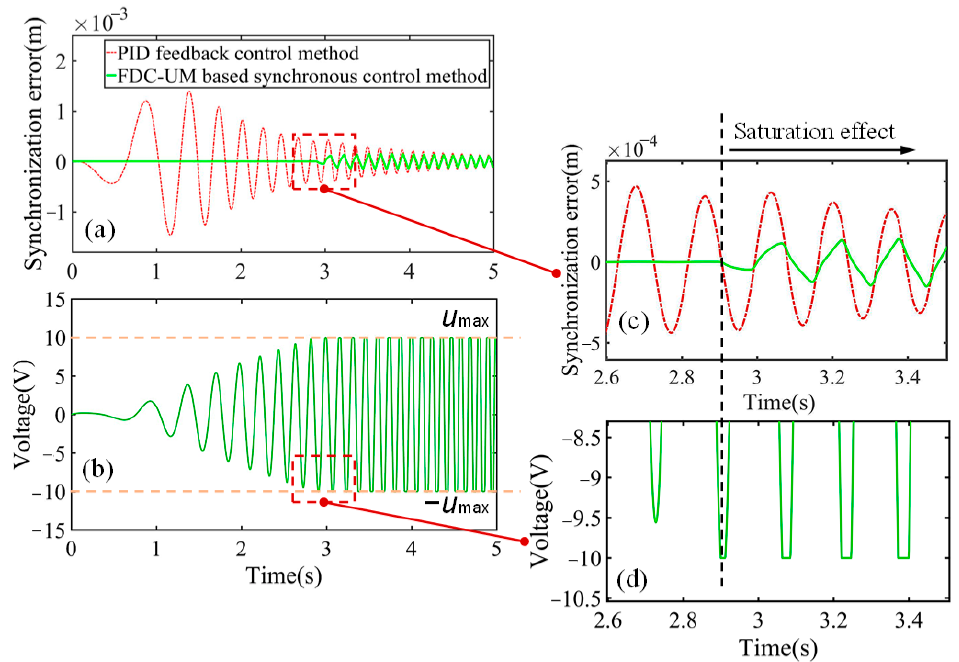
Figure 4. The saturation effect of the control voltage on the synchronization error of the dual-motor system: ( a ) under different control methods; ( b ) control voltage of the motor system in the range of [ − u max , u max ]; ( c ) partial enlarged view of ( a ); ( d ) partial enlarged view of ( b ).